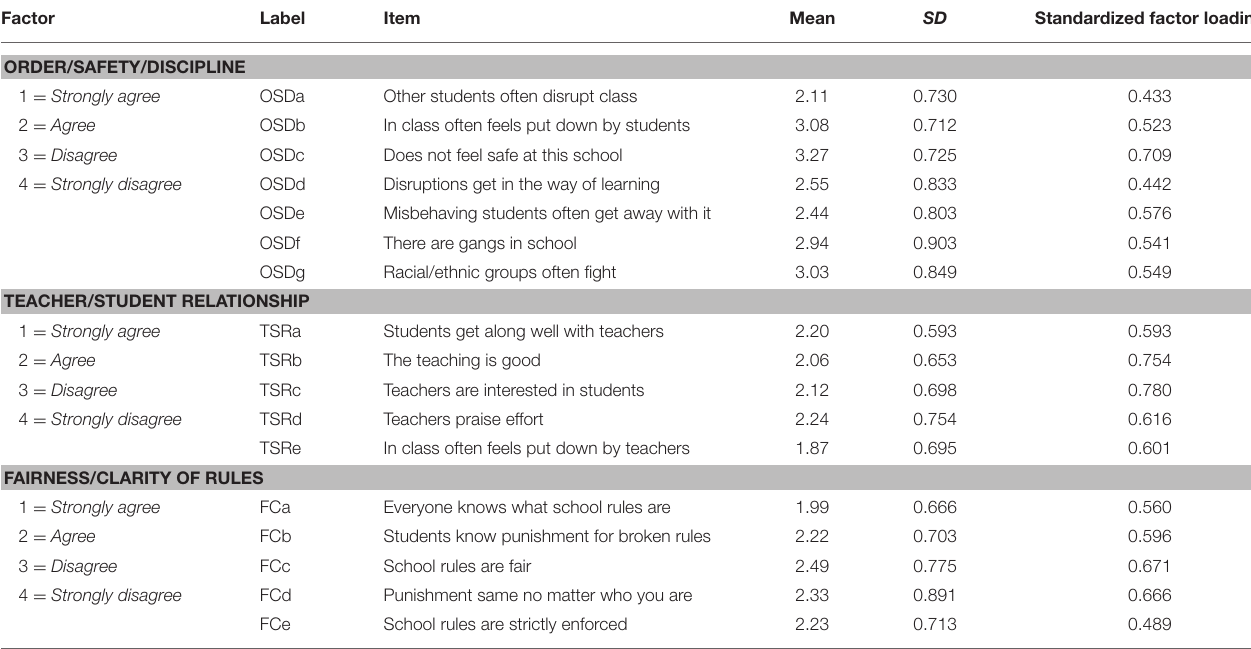
TABLE 1 | School climate items, means, standard deviations, and standardized factor loading. Factor Label Item Mean SD Standardized factor